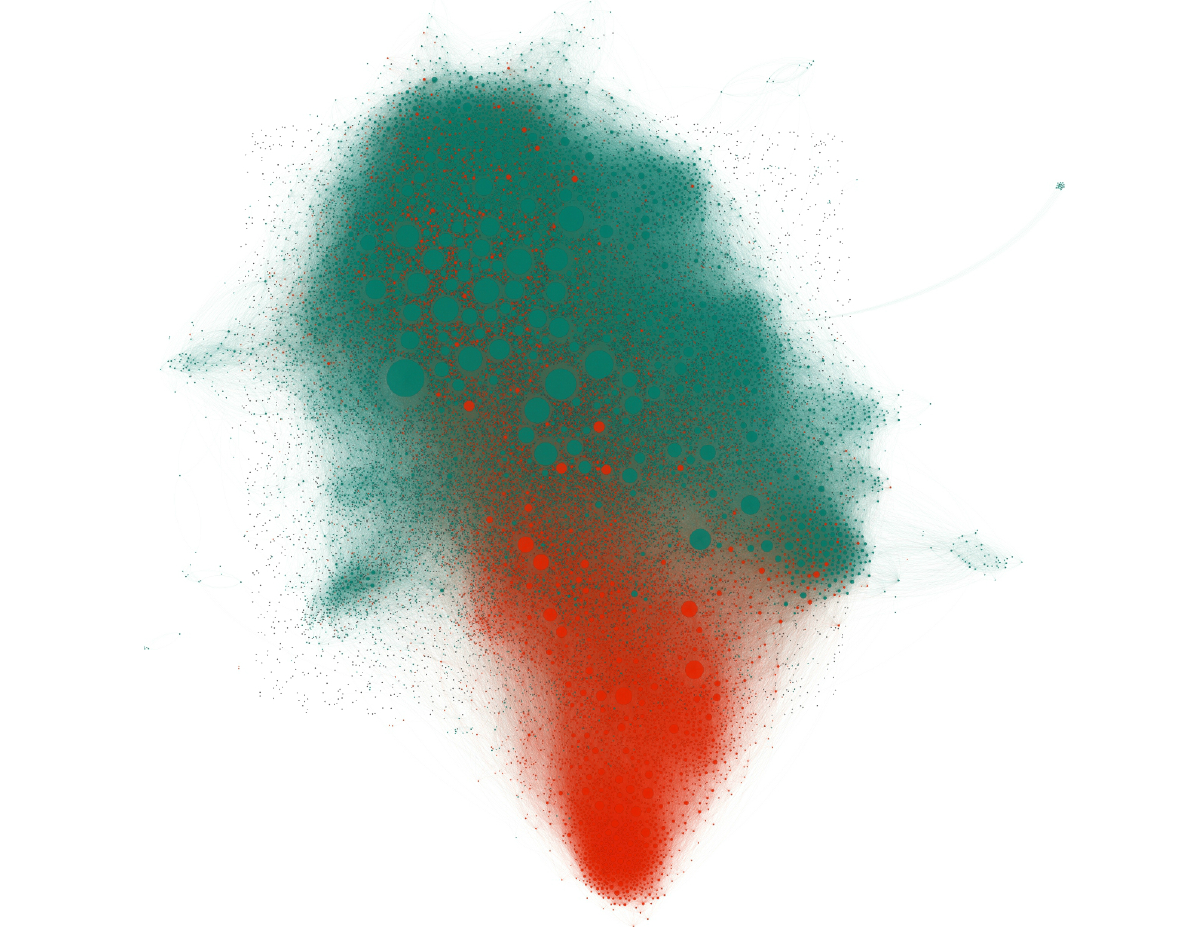
Figure 4. The network of 30,621 users that tweeted about HPV vaccines during the period between October 2013 and April 2014 organized via heuristic so that users are closer to other users with whom they are connected. The sizes of the nodes are proportional to the number of followers within the network. Users are colored according to information exposure (orange: those exposed to a majority of negative opinions; cyan: users that were exposed to mostly neutral/positive tweets; gray: users not exposed to HPV vaccine